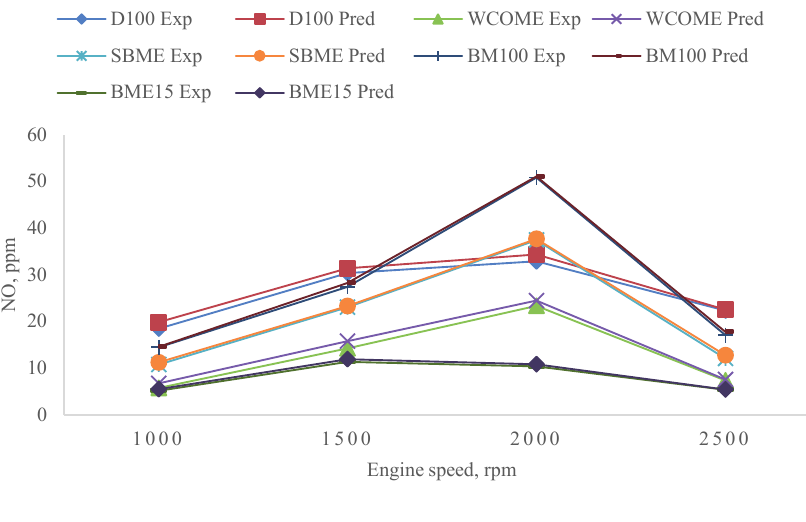
Fig. 6. Variation of NO emissions with engine